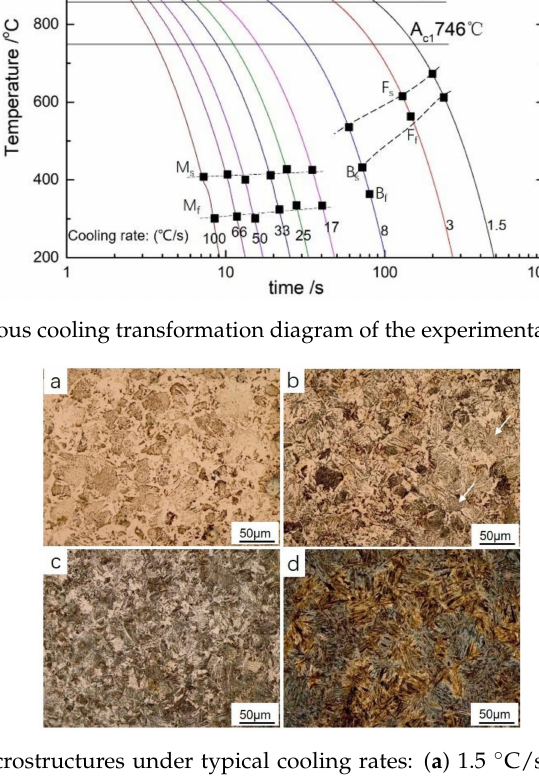
Figure 4. Optical microstructures under typical cooling rates: ( a ) 1.5 ◦ C/s, ( b ) 3 ◦ C/s, ( c ) 8 ◦ C/s, ( d ) 17 ◦ C/s.